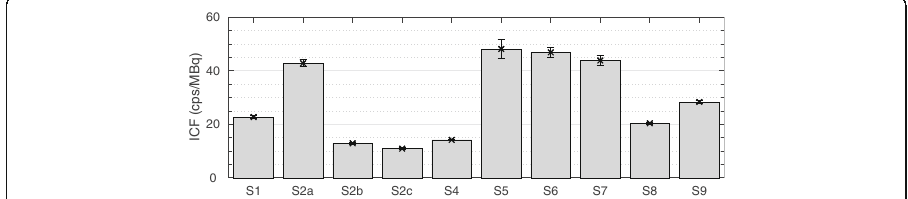
Fig. 4 Setup-specific image calibration factors (ICF). Details about the individual setups can be found in Table